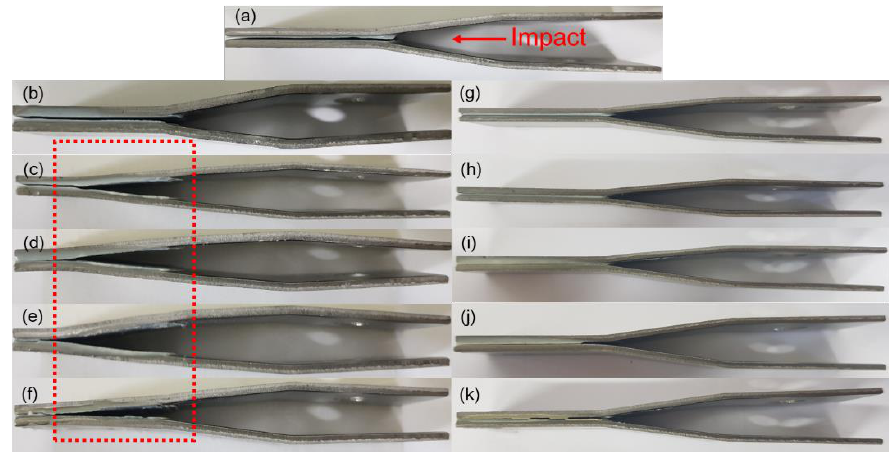
Figure 9. Photos of specimens after the IWP test: ( a ) control; ( b ) 5 wt % PTPU; ( c ) 10 wt % PTPU; ( d )